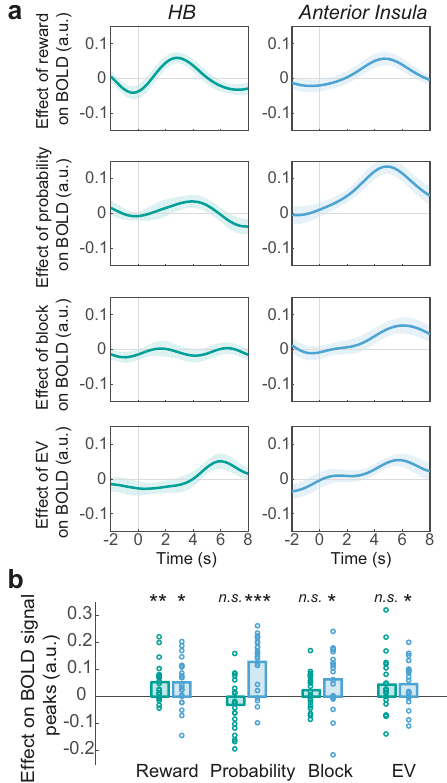
Fig. 5 Anterior insula tracks individual component features of the environment. a ROI time-course analysis showing the relationship between BOLD activity in habenula (HB) (left side panels) and anterior insula (right side panels) with reward magnitude, reward probability and block type (poor vs. rich) on the current trial, and the expected value (EV) of the offer on the previous trial. Format as in Fig. 2a. The lines and shadings show the mean and standard error of the β weights across the participants, respectively. Time zero is the trial onset (appearance of the offer). Note that the hemodynamic lag means that a BOLD signal change re fl ects neural activity approximately 6 s earlier. b There was a signi fi cant relationship between BOLD activity in insula (blue boxes) and all four contextual factors (Reward, P = 0.03; Probability, P = 2.25E − 05; Block, P = 0.03; EV, P = 0.02). In HB (green boxes) reward magnitude was the only component factor that correlated with BOLD signal ( P = 0.005). Each ring represents one participant ( n = 22). Signi fi cance testing on time-course data was performed by using a leave-one-out procedure on the group peak signal. Two-sided, one-sample t tests with Holm − Bonferroni correction. * P <